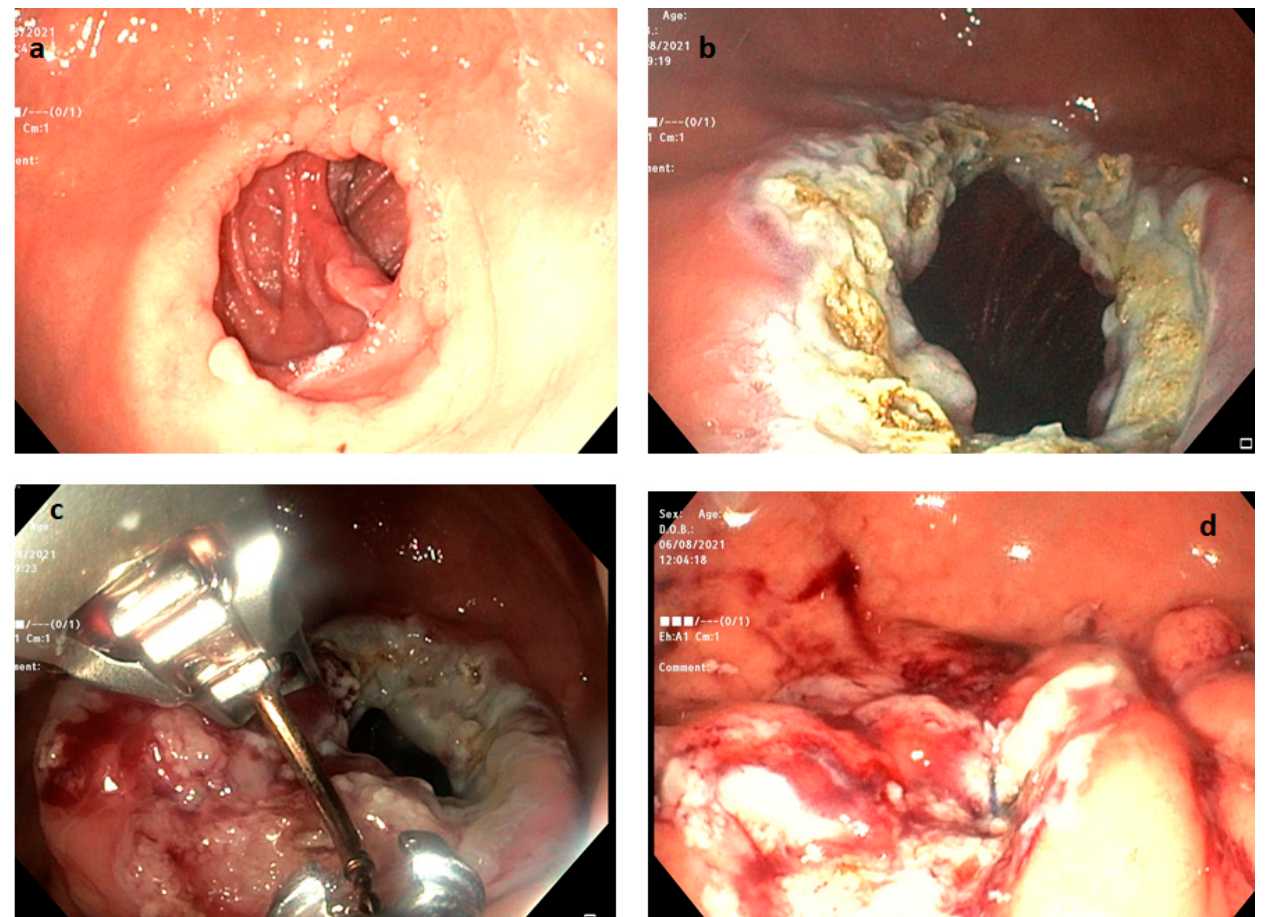
Figure 3. Endoscopic steps of the transoral outlet reduction endoscopic (TORe) procedure: ( a ) visualization of the dilated GJA; ( b ) APC application at the level of GJA; ( c ) suturing performance with OverStich™ system; and ( d ) final GJA at the end of the procedure. GJA, gastrojejunal anastomosis; APC, argon plasma coagulation.